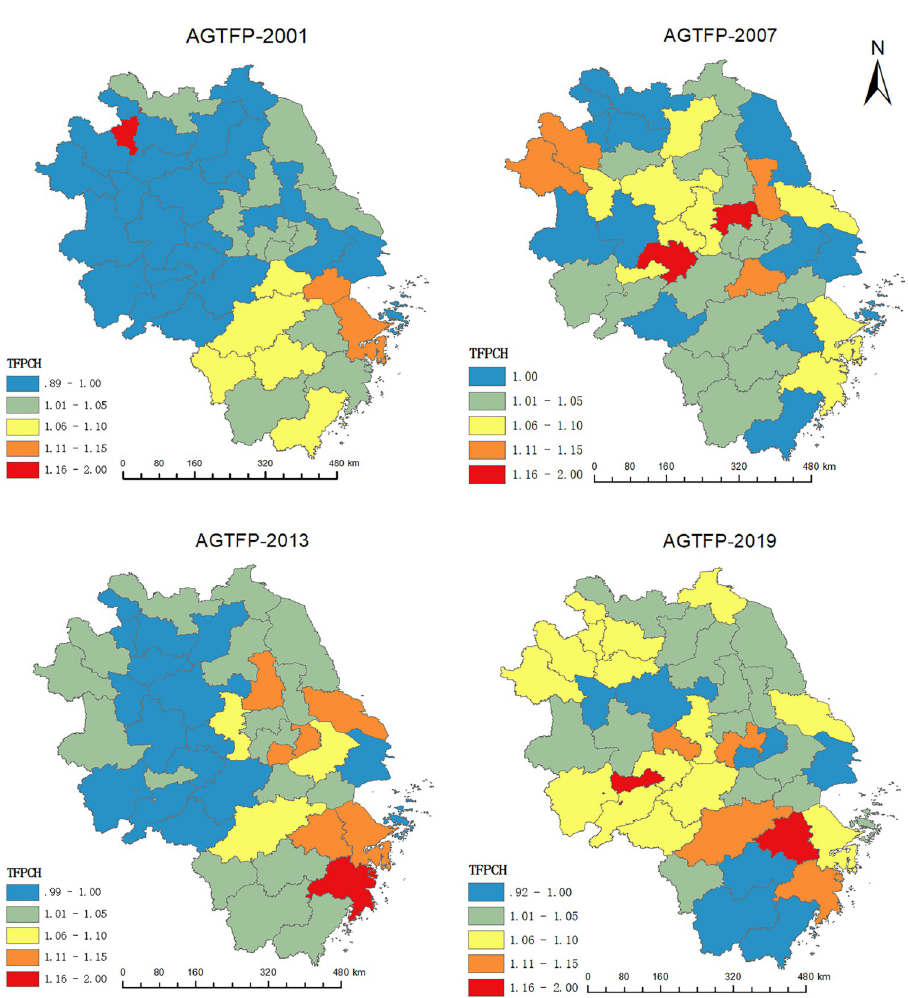
Fig 2. Spatial evolutionary characteristics of AGTFP (Quoted from the Tianditu map. Source of base map: The open source map data service provided by the National Platform for Common GeoSpatial Information Services)